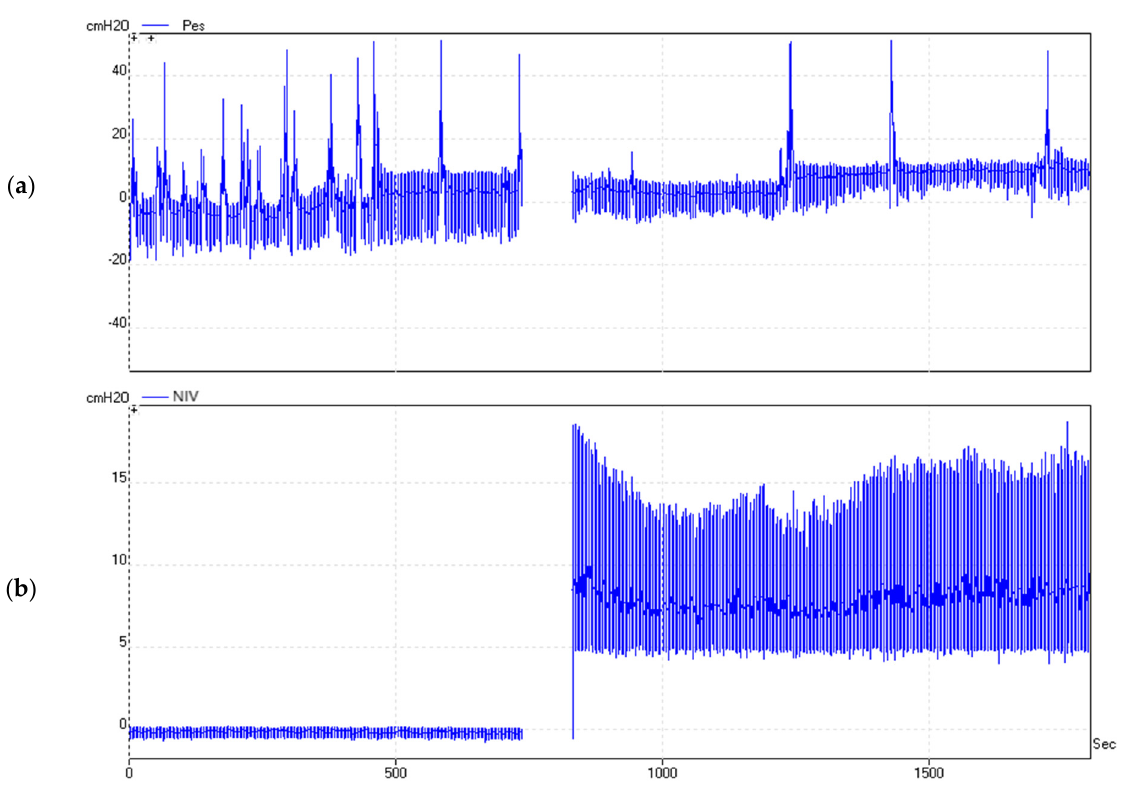
Figure 1. Real-time measurement of Pes ( a ) and Paw ( b ) for 30 min. Significant variation of Pes can be observed depending on the patient’s position and the presence of NIV. Paw, airway pressure measured at the mask level during noninvasive ventilation.